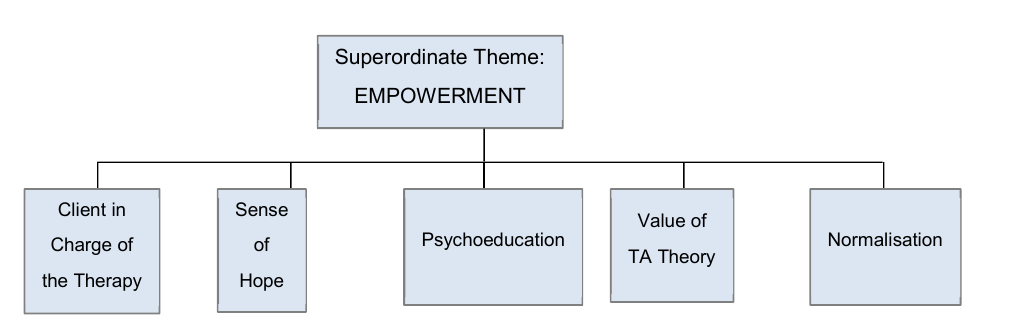
Figure 11: Superordinate Theme 2: Therapist